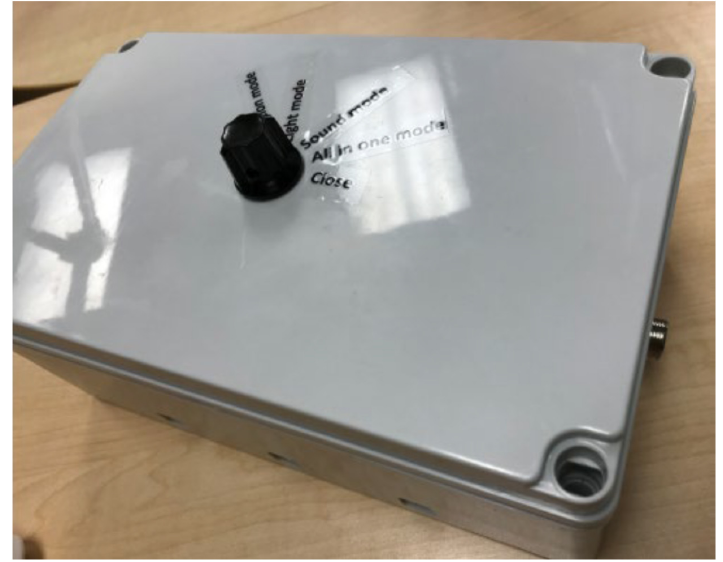
Figure 4. HUGS ‐ 1 electronic box with analog dial.